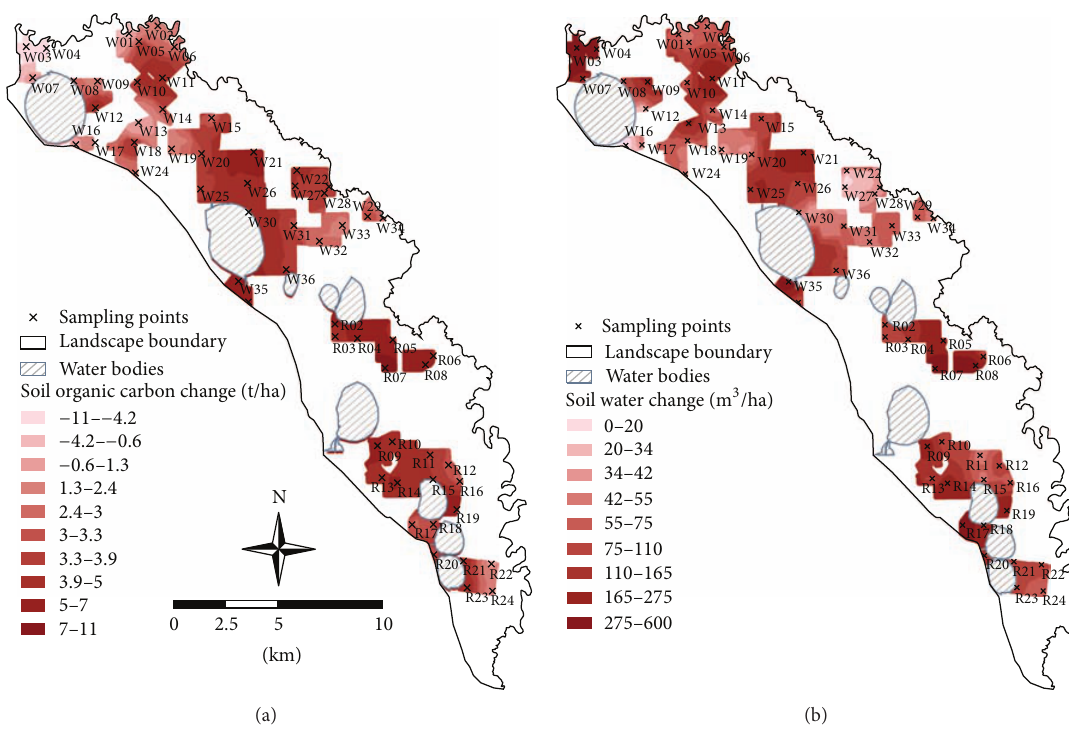
Figure 3: Predicted changes in service indicators, (a) soil organic carbon content and (b) soil water storage, to 30cm depth in the study area associated with changes from current (time = 0) to future (time = 25 years) land-use scenarios. Each prediction surface represents differences in the supply of services between an average day under the current scenario and an average day under the future scenario.